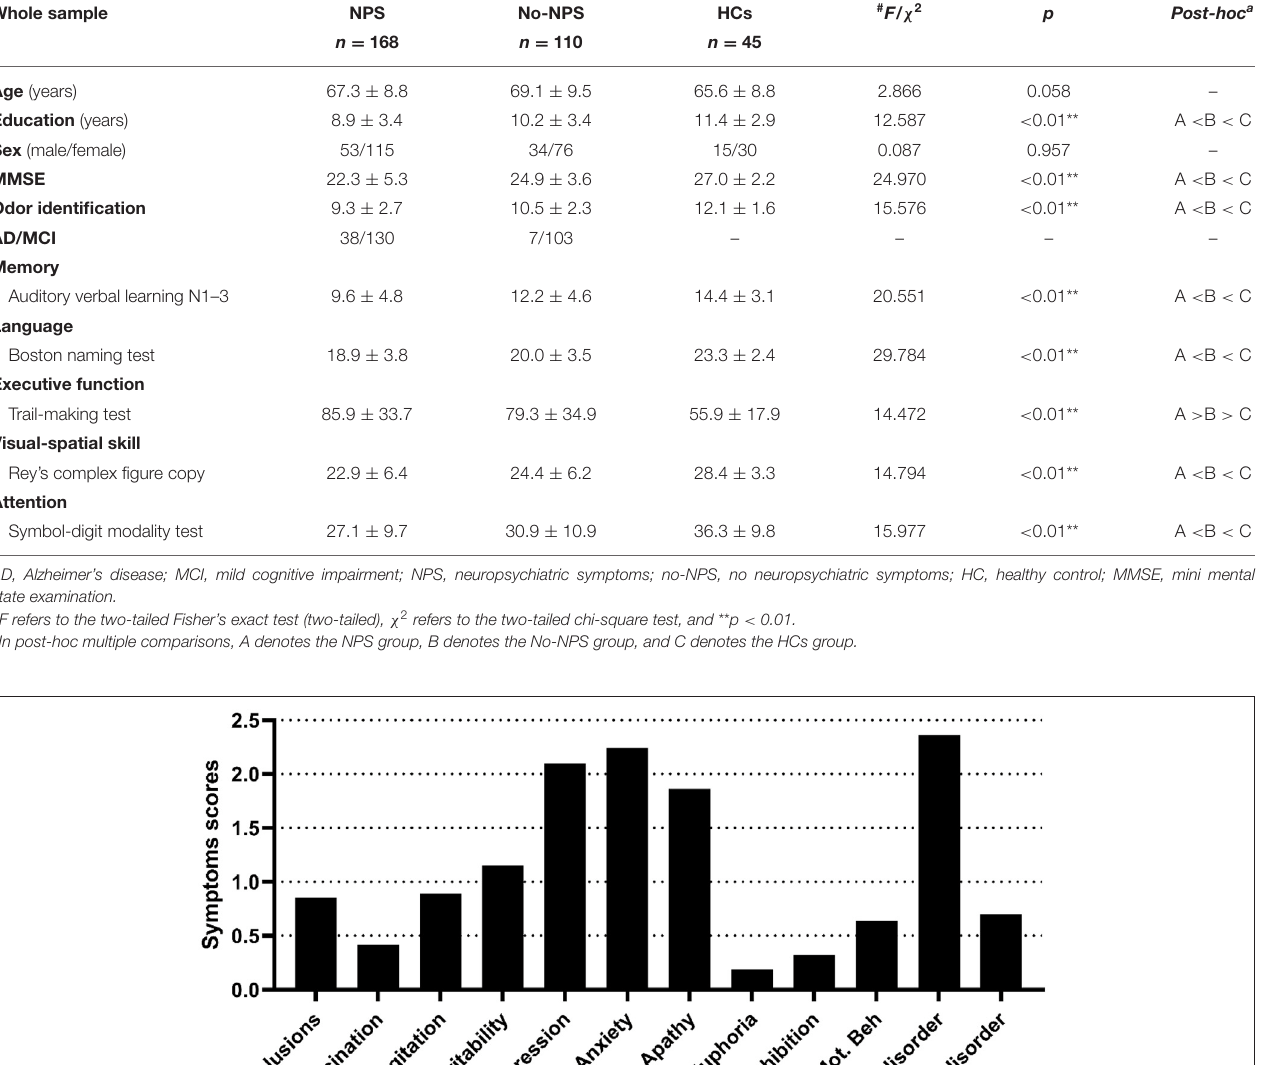
respectively. The total explanatory power of the three factors represented 55.4% of the total